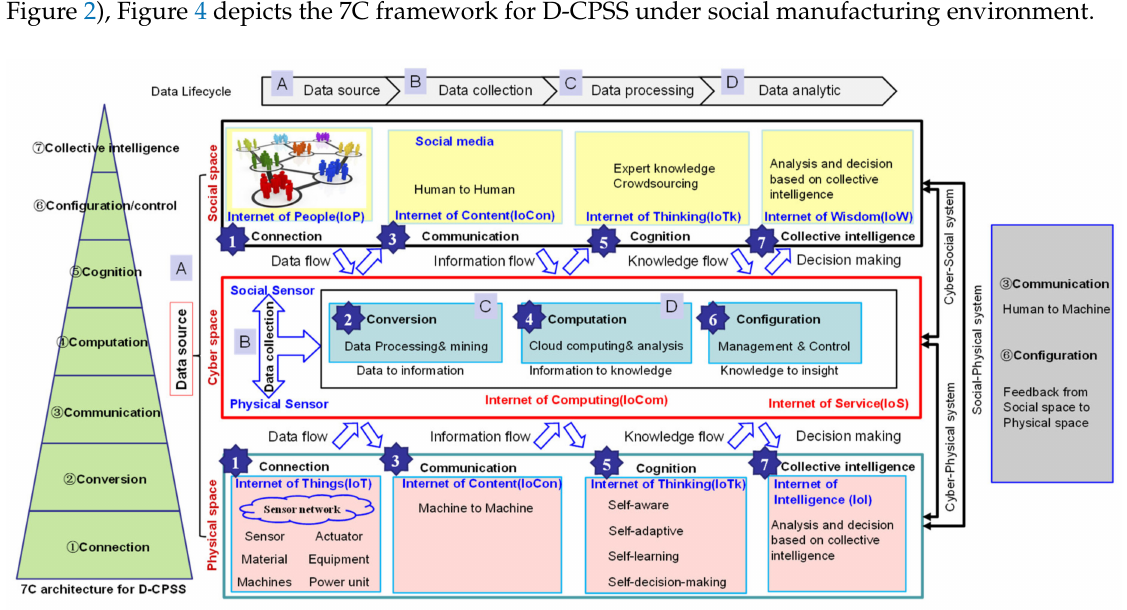
Figure 4. The 7C framework for D-CPSS towards social